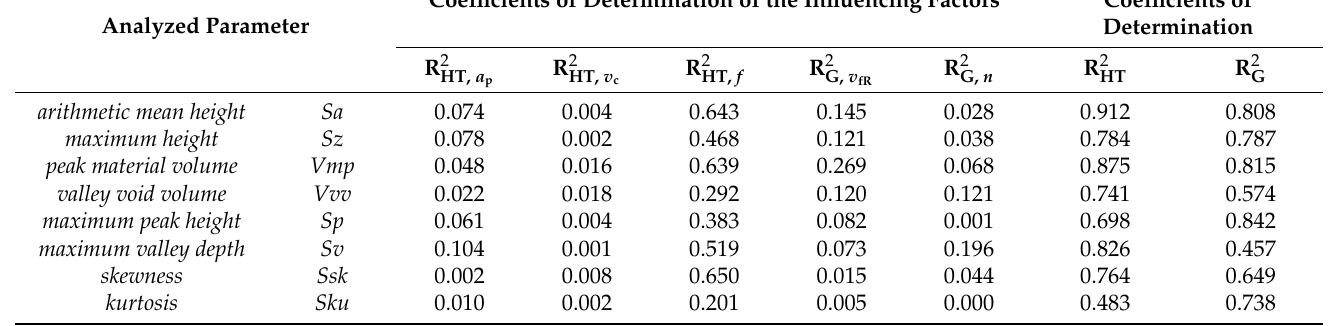
Table 6. Coefficients of determination of the influencing cutting data and the multifactorial coefficients of